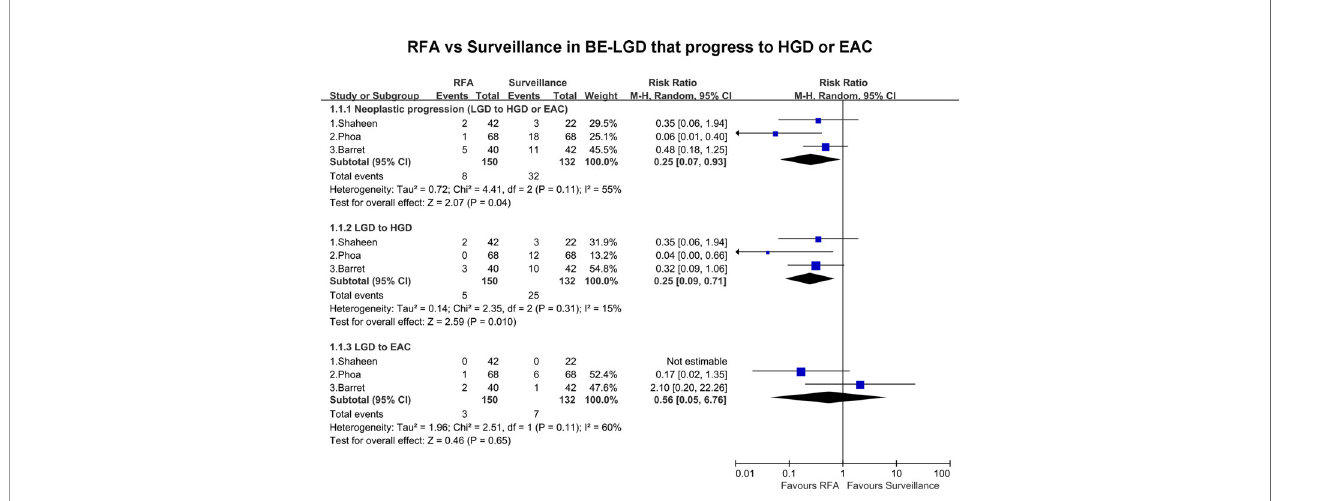
FIGURE 2 | Pooled risk of BE-LGD progression to HGD or EAC (RFA vs.